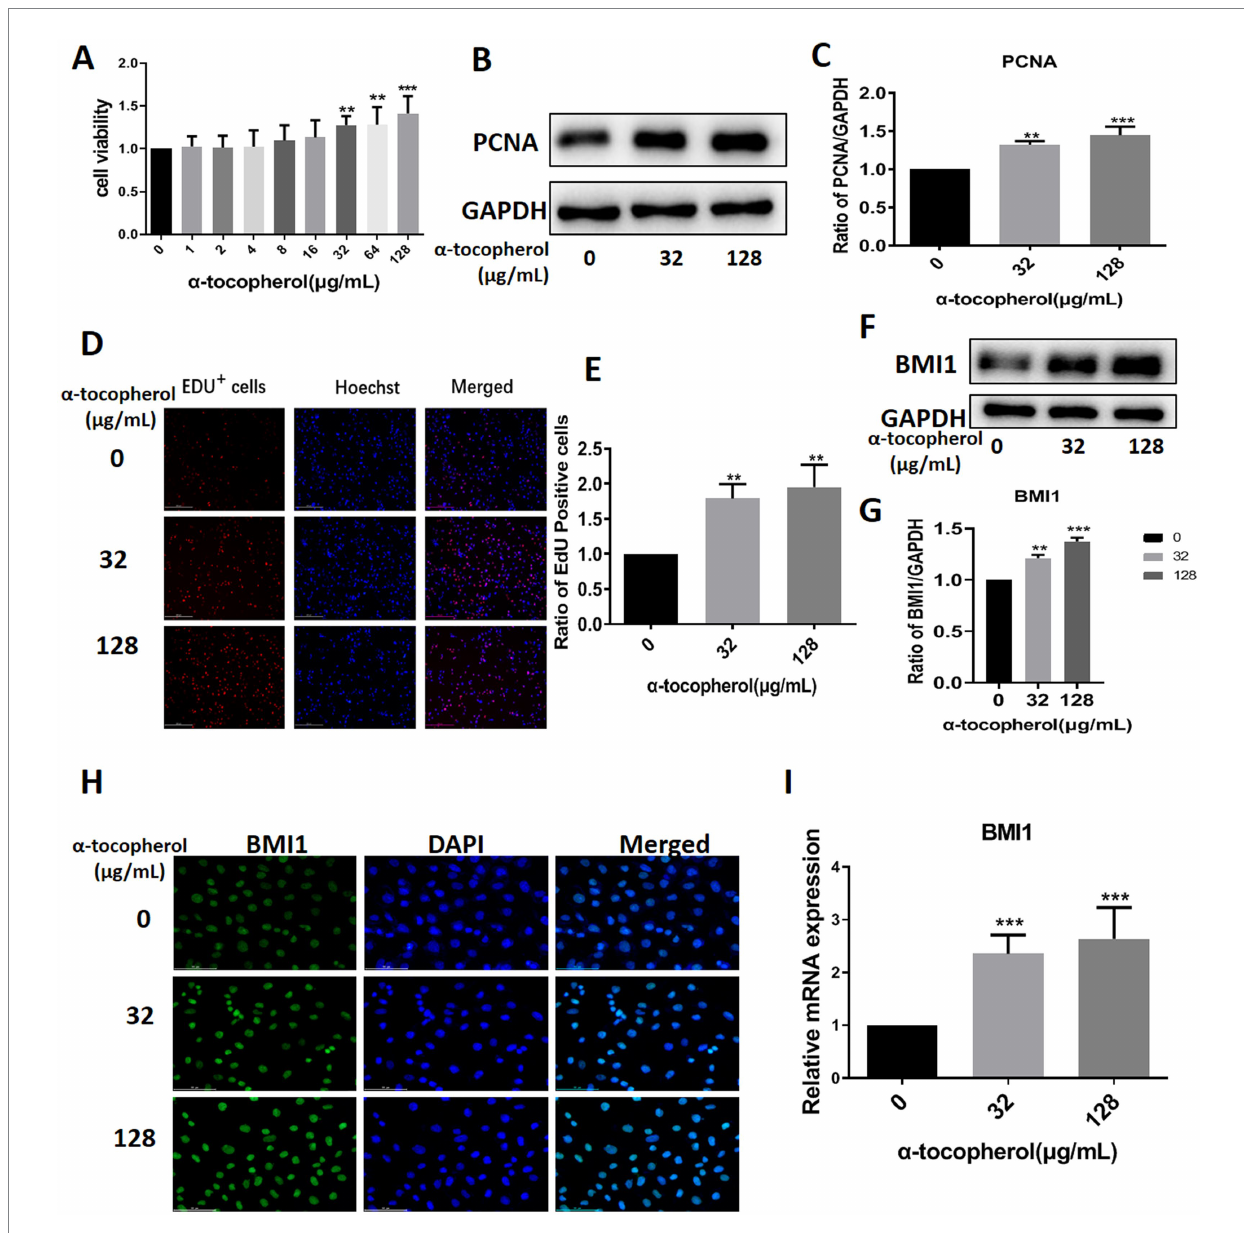
α -tocopherol promoted mouse SSC proliferation and up-regulated BMI1